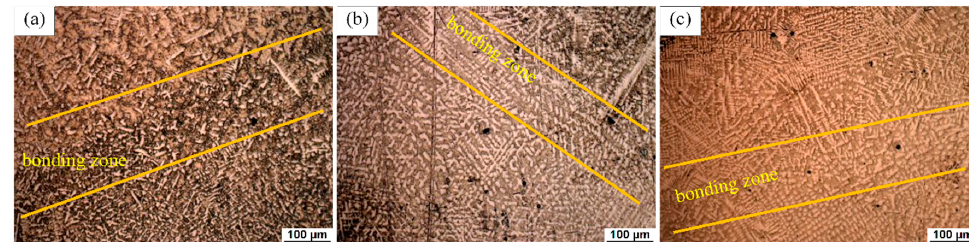
Figure 5. The microstructure of the bonding zone between the second and third layers in ( a ) sample LC1; ( b ) LC2; ( c ) LC3.